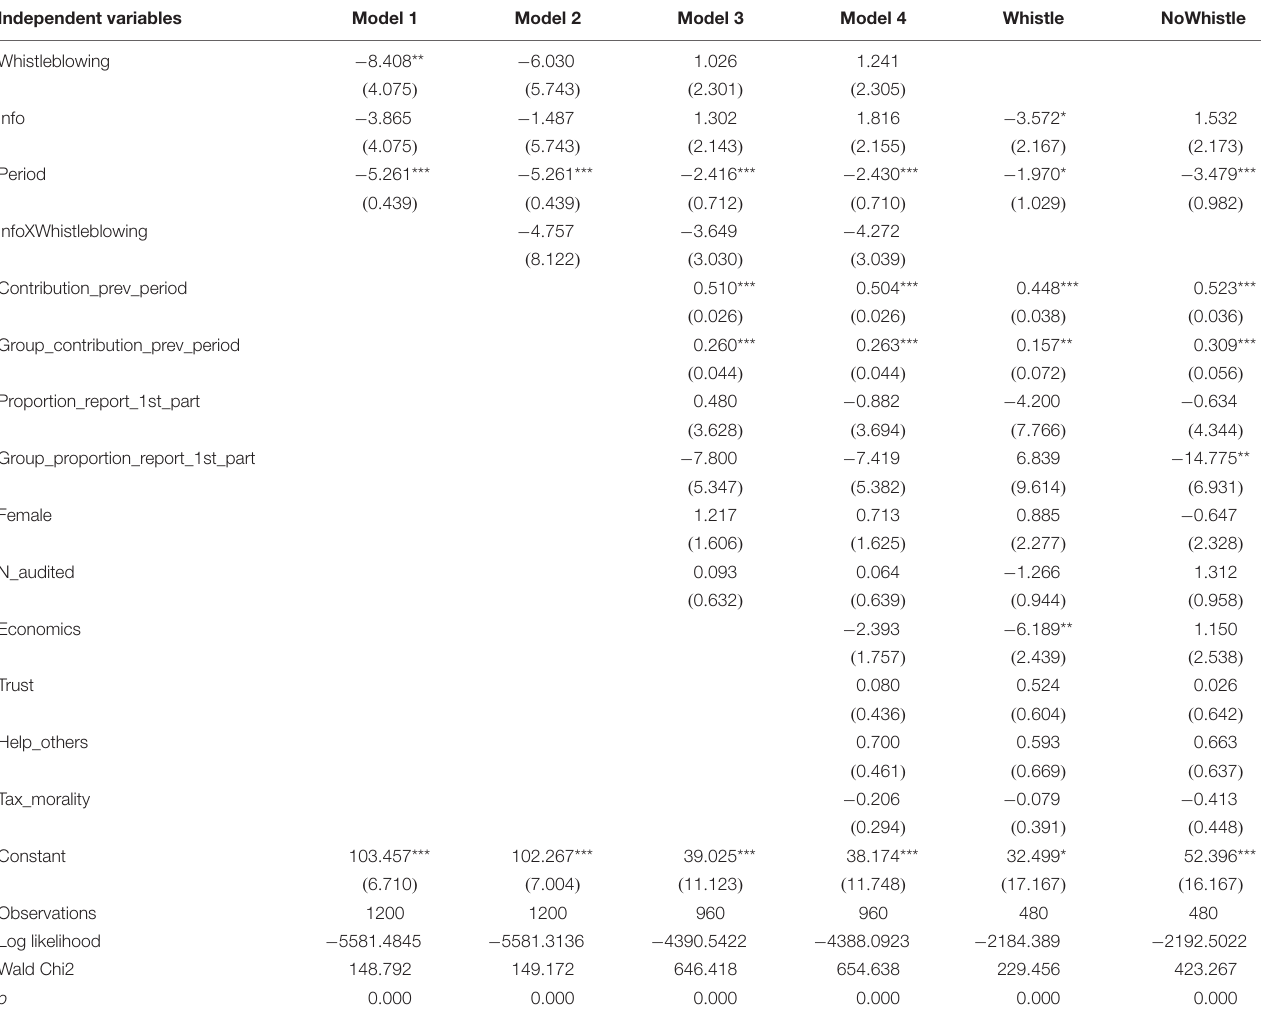
TABLE 3 | Multilevel regressions. Amount contributed in the Generalized Gift Exchange game. Independent